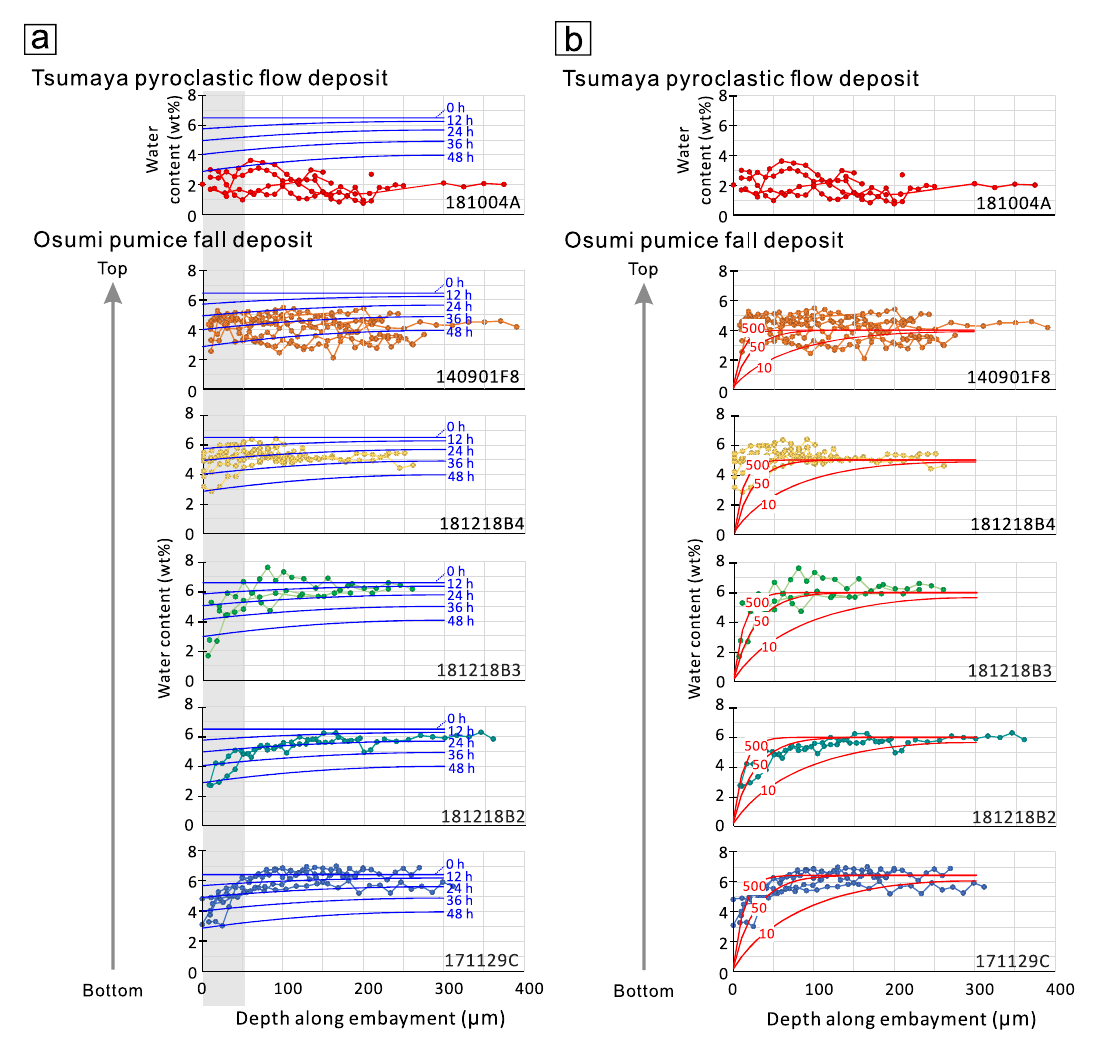
Fig. 3 Two-step dehydration. a Distributions of water content along a 300- μ m-long melt embayment calculated by the one-dimensional diffusion model. The decompression rate is assumed as 1 × 10 3 Pa s − 1 . The initial water content is 6.5 wt%. The distributions of water 12, 24, 36, and 48 h after the start of decompression are shown. The measured data of water contents shown in each panel are the same as those in Fig. 2a. The gray hatched area (~50 μ m from the entrance of the embayment) is considered to be affected by the rapid dehydration in the second decompression step and/or post-eruption hydration. b Diffusion pro fi les formed in the embayment when the magma is decompressed to atmospheric pressure at different decompression rates, calculated by the one-dimensional diffusion model (red solid line). The numbers shown in the pro fi les indicate the decompression rate (×10 3 Pa s − 1 ). The initial water content of sample 171129C is 6.5 wt%, samples 181218B2 and 181218B3 are 6.0 wt%, 181218B4 is 5.0 wt%, and 140901F8 is 4.0%, decreasing with the progress of the